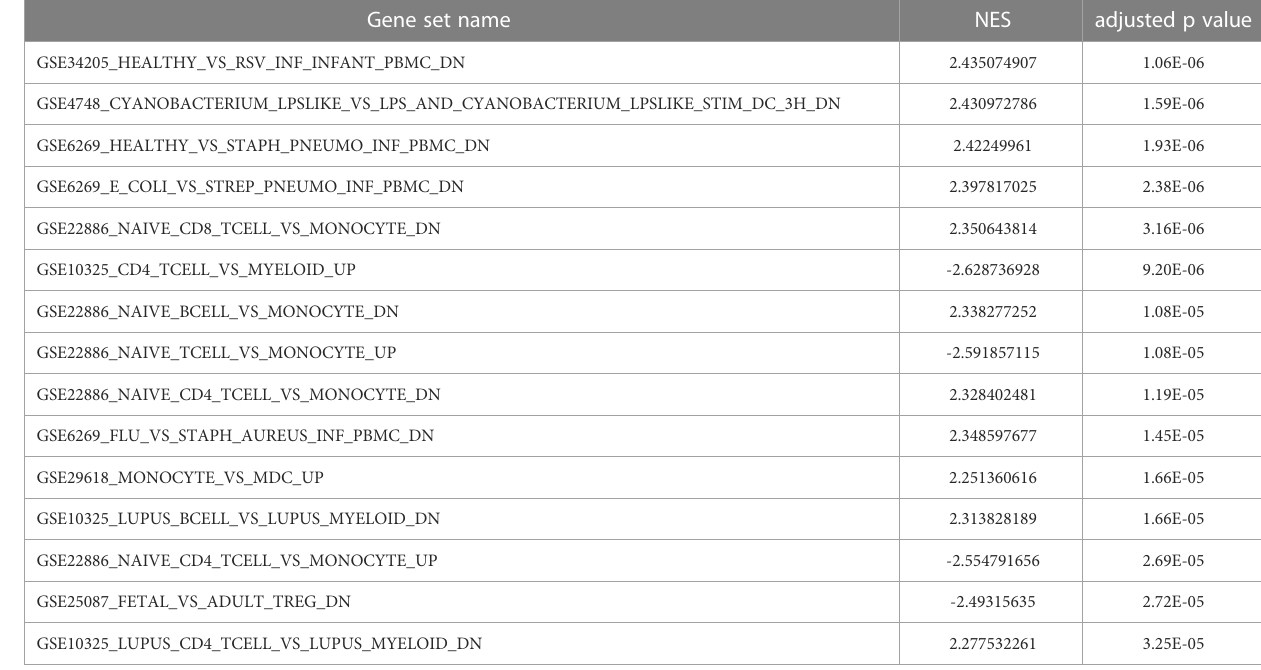
TABLE 3 Top 15 signi fi cant immunological signatures enriched by immunity in GSEA of the AISA grade of SCI.